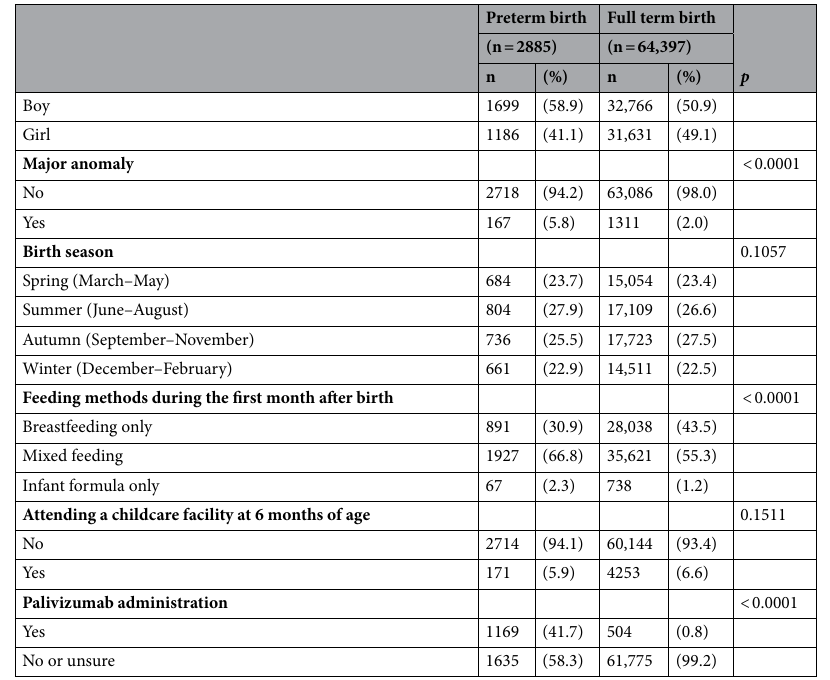
Table 1. Characteristics of the